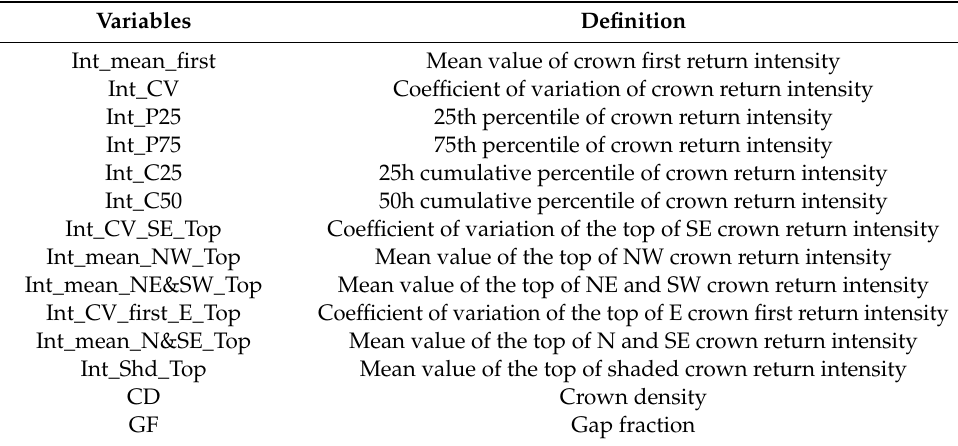
Table 4. Features selection of lidar metrics.